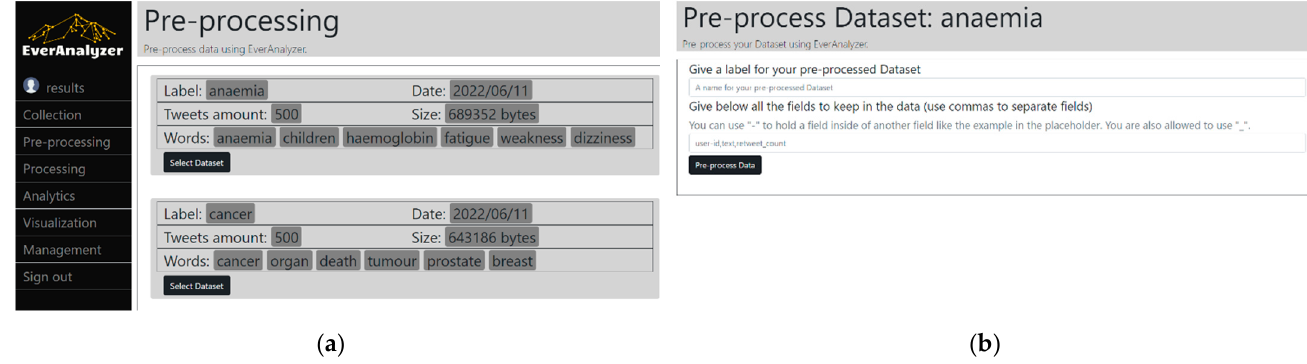
Figure 16. ( a ) Collected datasets; ( b ) Pre-processing form.